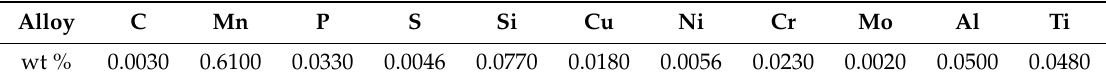
Table 1. Chemical composition of the steel sheets used in the experiments.